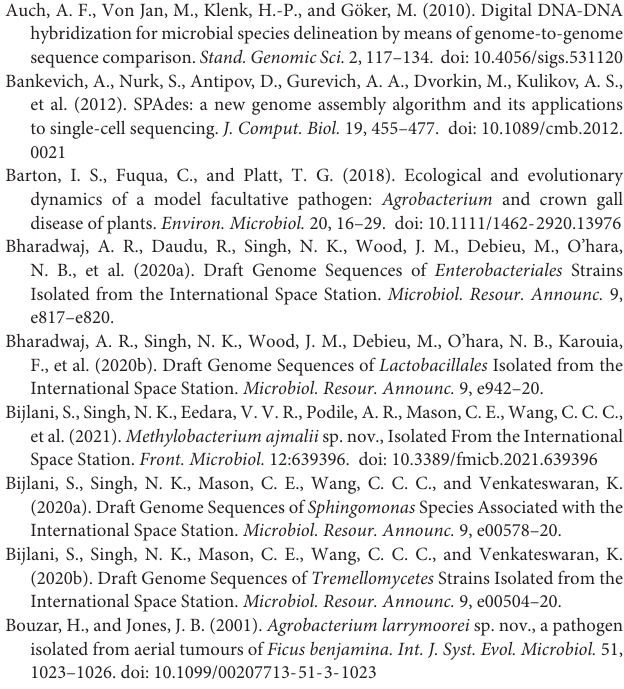
genes with genetic mobility-related functions is based on the Prokka annotation of